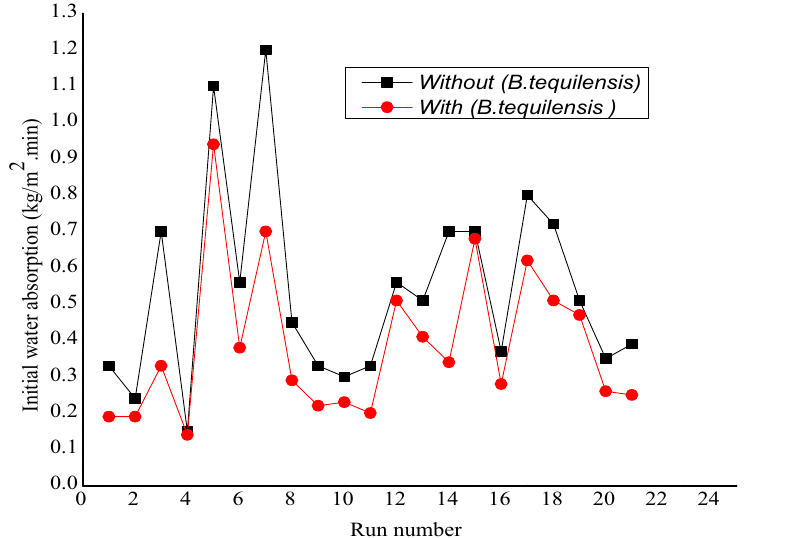
Figure 4. The initial water absorption of FCB and